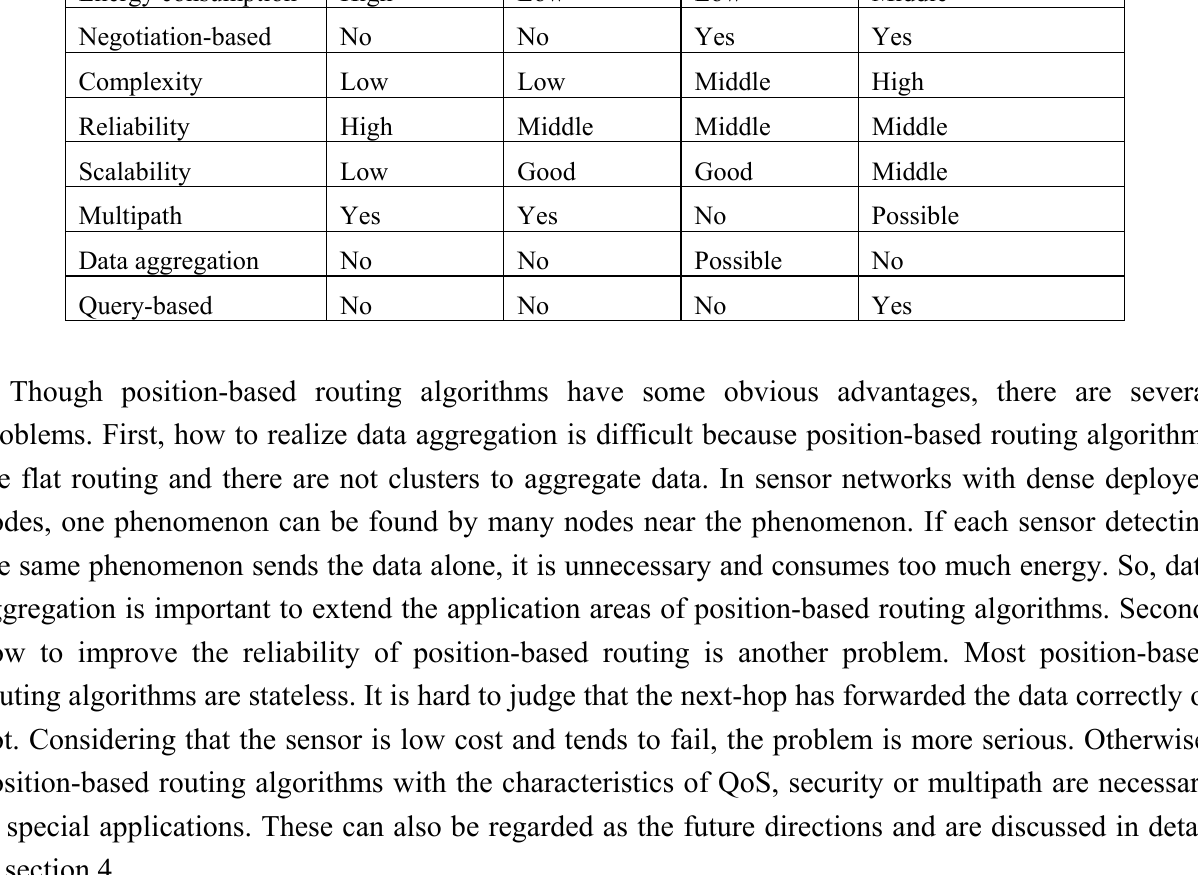
Table 3. Comparison among four kinds of position-based routing algorithms. Flood-based Curve-based Grid-based Ant algorithm-based Energy consumption High